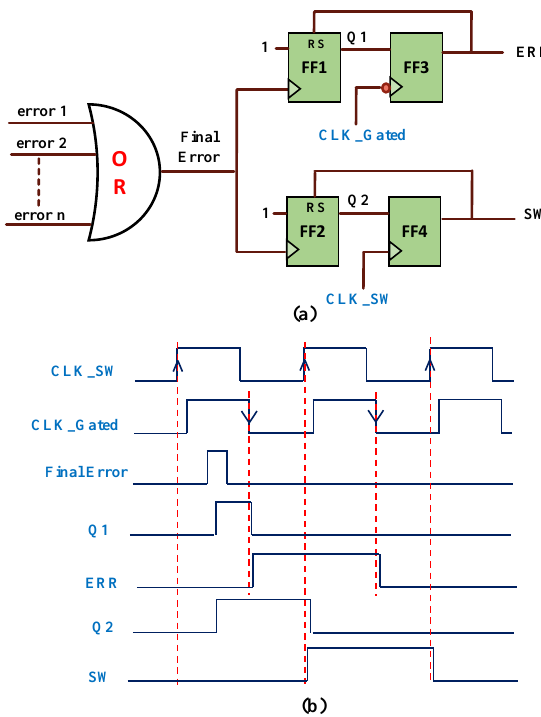
Figure 2. ( a ) Control signal circuit and ( b ) its timing